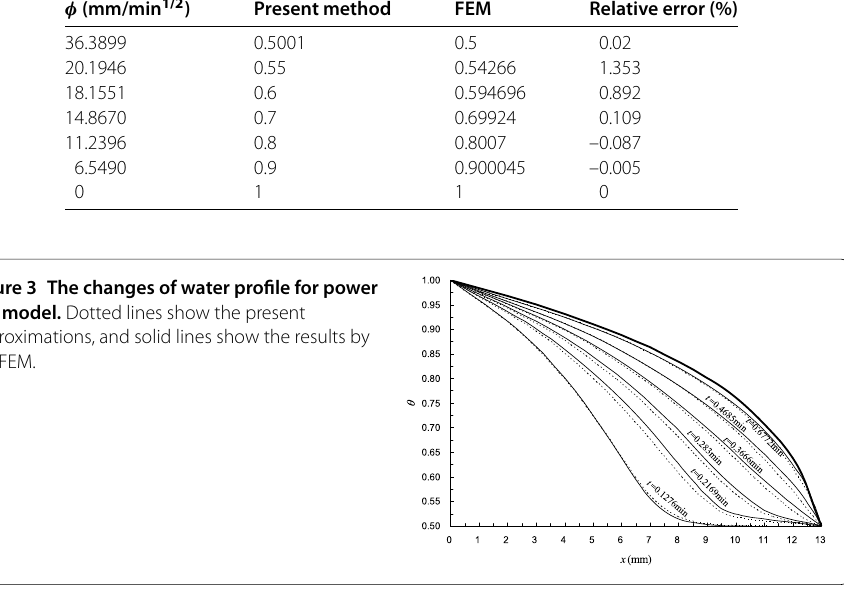
Table 1 Results of θ obtained from the FEM and fifth-order approximation